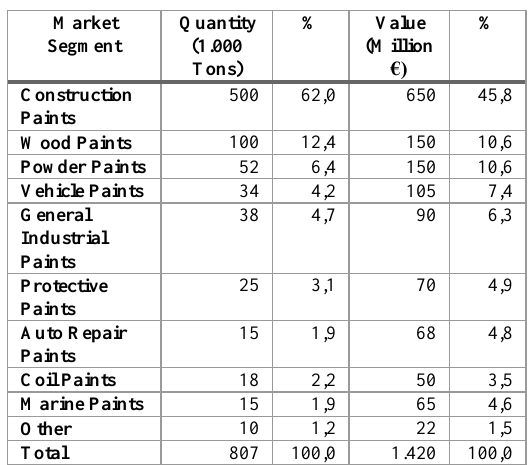
Table 5: Quantities and Values of the Turkish Paint Market Segments (Year